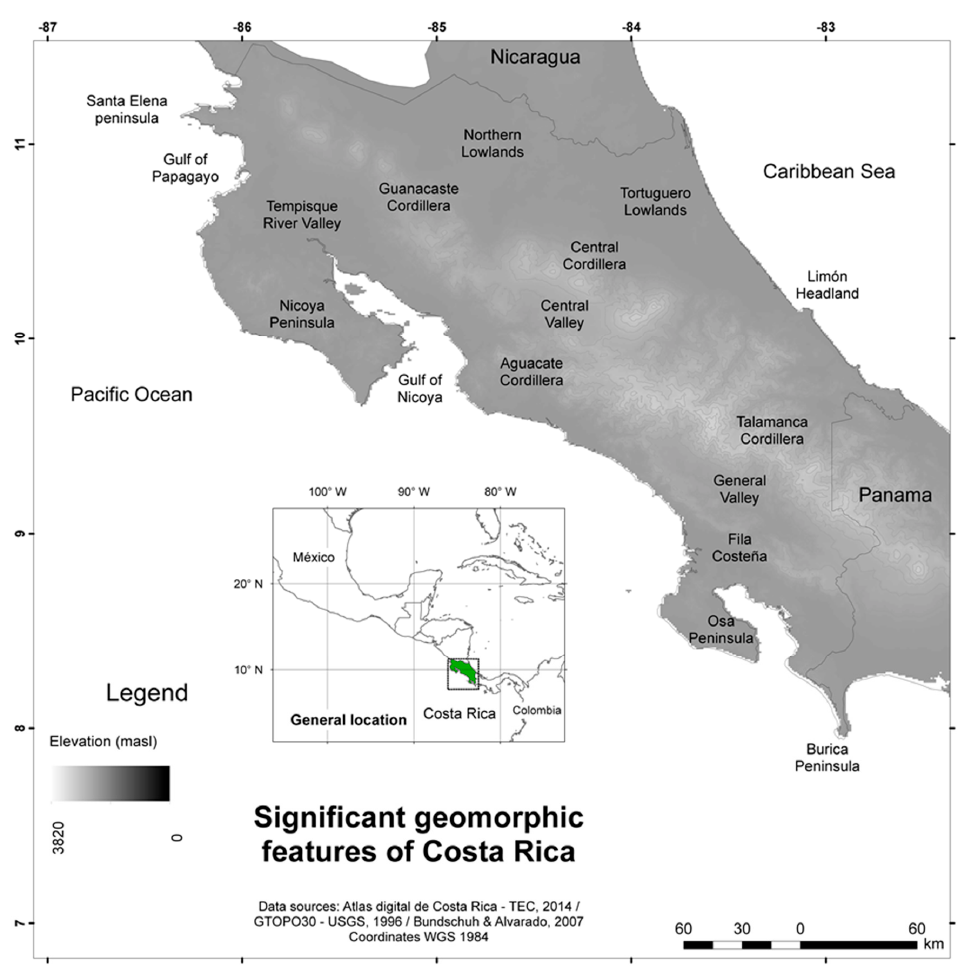
Figure 1. Main geomorphic features of Costa Rica based on Bundschuh and Alvarado [4] with base digital elevation model by the USGS [8].